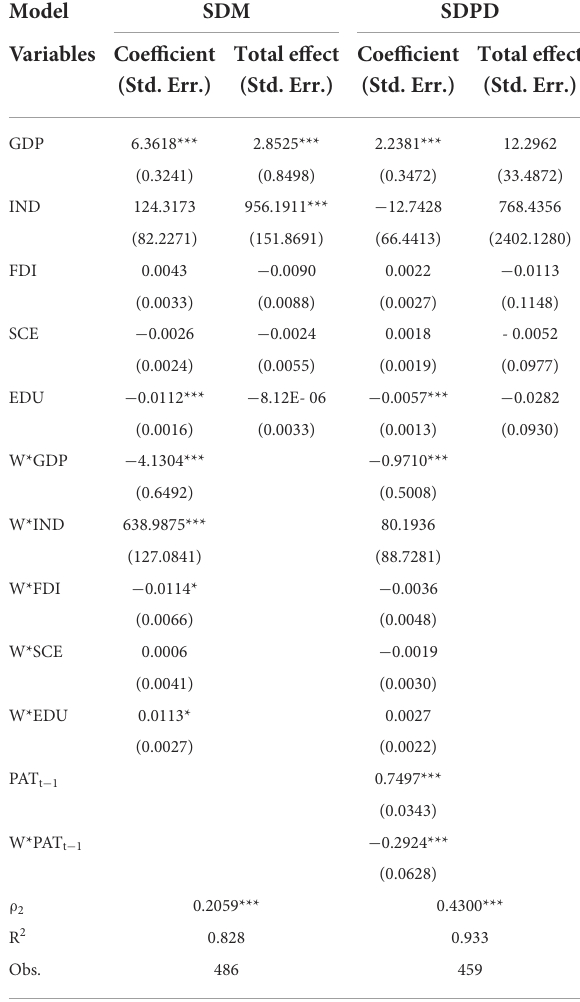
TABLE 5 Regression model results of influencing factors of TI